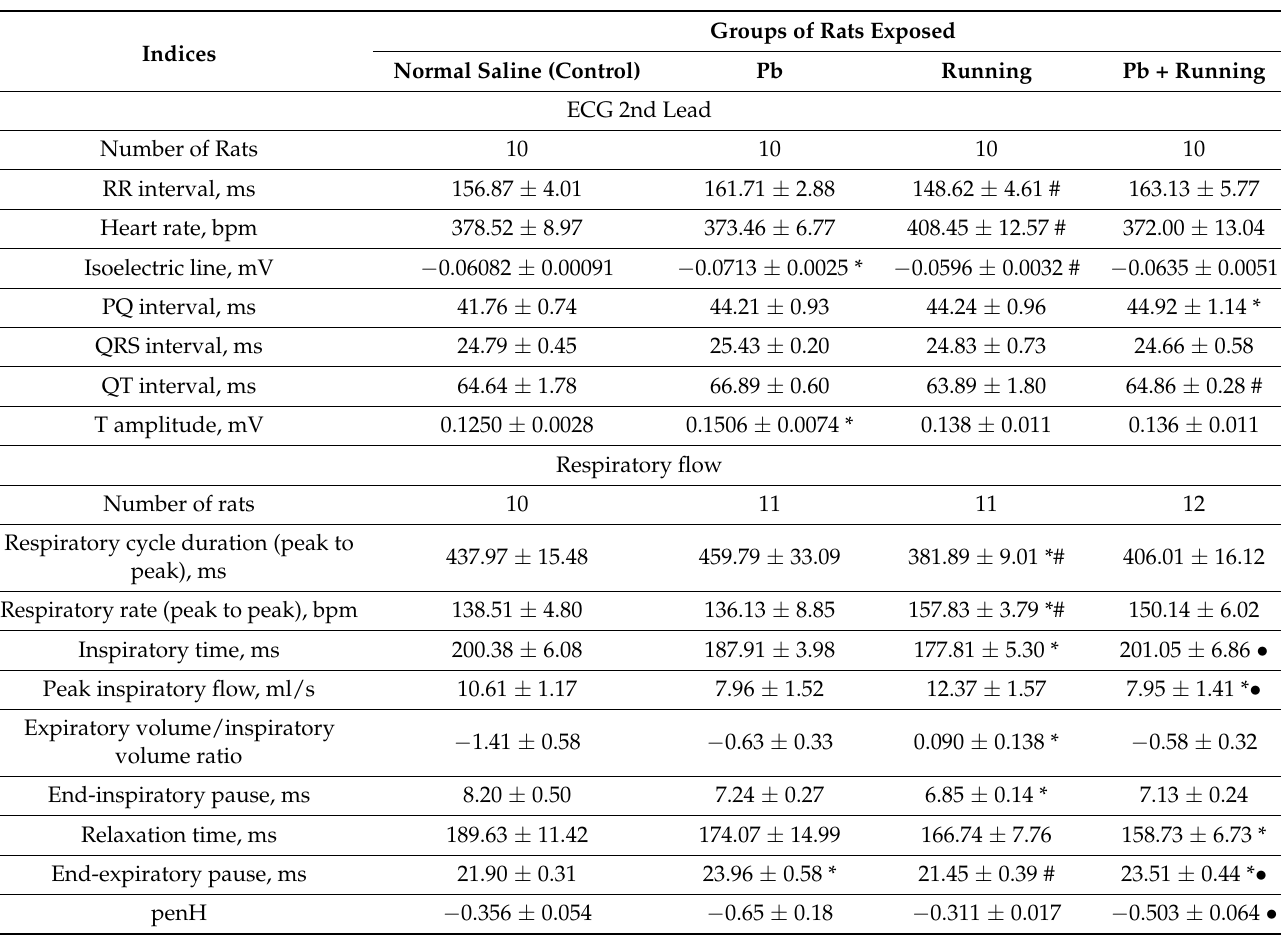
Table 2. Electrocardiographic